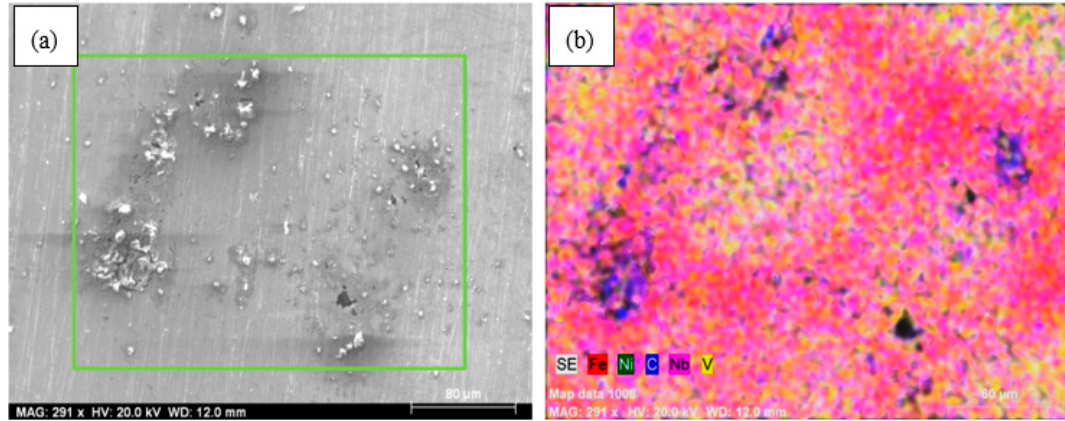
Figure 10. ( a ) SEM image and ( b ) mapping analysis of the alloy 2-NbV-0Ni after corrosion. Materials 2020 , 13 , x FOR PEER REVIEW